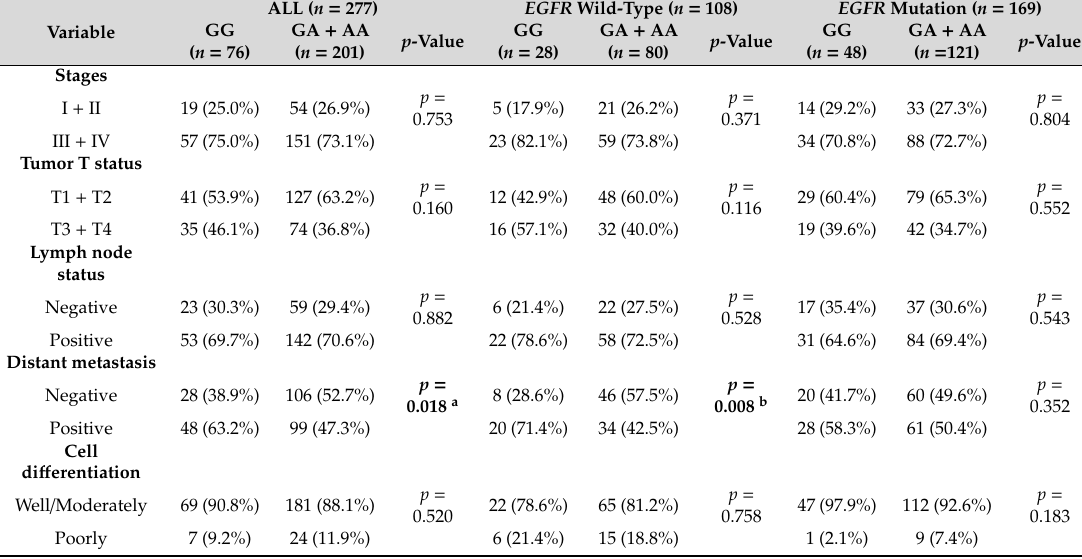
Table 4. Clinicopathologic characteristics of lung adenocarcinoma patients with EGFR mutation, stratified by polymorphic genotypes of FGFR4